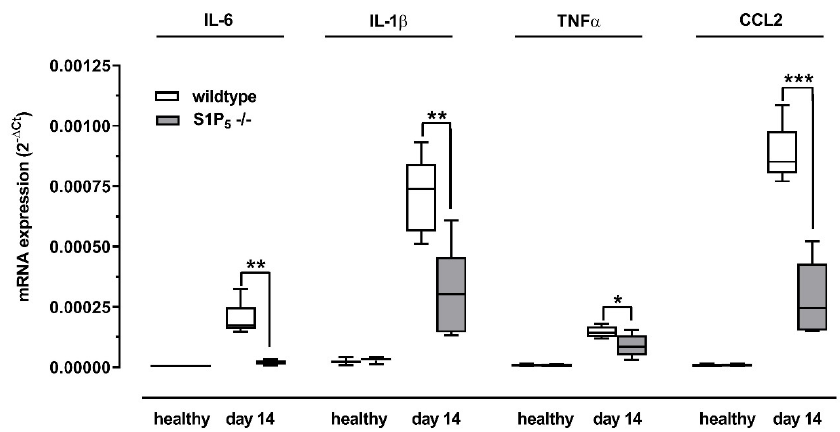
Figure 4. Gene expression of proinflammatory cytokines. Expression levels of genes were compared between wild-type and S1P 5 knockout mice (S1P 5-/- ) without and with an adenine-rich diet for 14 days. Expression levels of Il-6, Il-1 β , Tnf α , and Ccl2 mRNA were determined by TaqMan ® analysis as described in Material and Methods. The internal standard used was 18 s ribosomal RNA. Data are shown as box plots with a line at the median and whiskers from minimum to maximum value; n = 5–9; * p ≤ 0.05; ** p ≤ 0.01; *** p ≤ 0.001 as indicated.